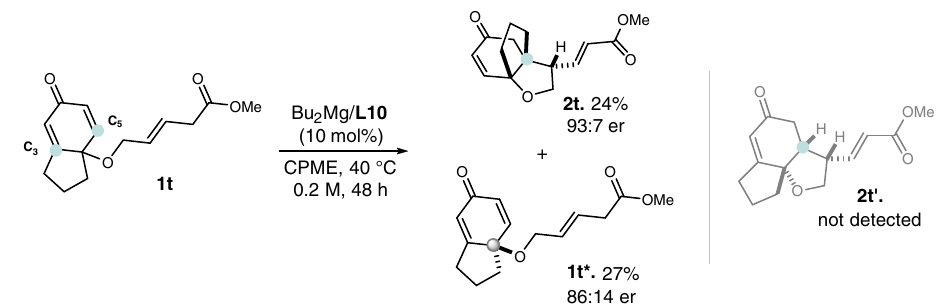
Fig. 4 Further extensions of the substrate scope of the KR reaction. All yields shown were based on isolated products. er values were determined by chiral HPLC analysis.